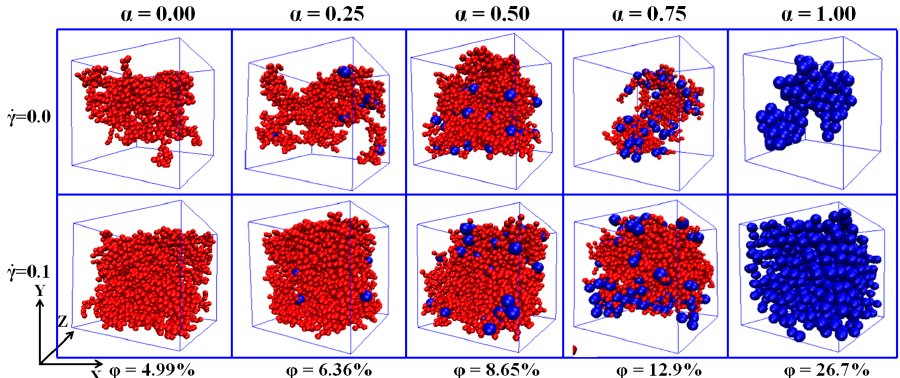
α . ). α γ = 0.0 and 0.1 for different ratio ( α ). ).